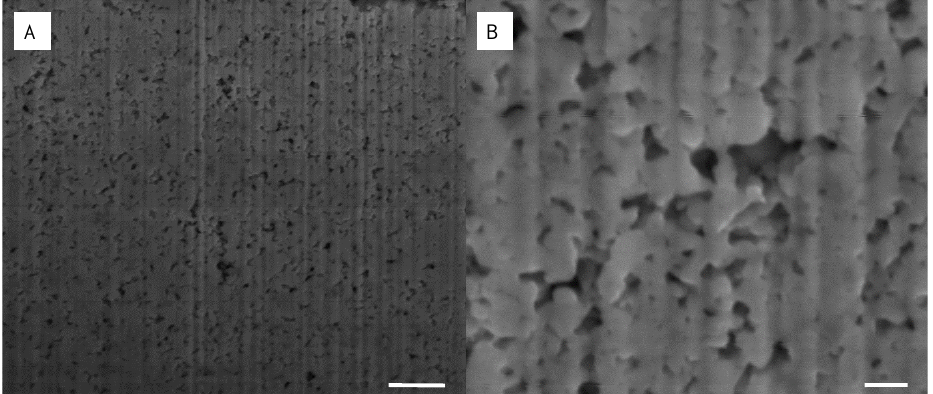
Figure 5. Representative SEMs of the cross-section of an etched 10 wt% SiO 2 -Ag composite; scale bars of ( A ) and ( B ) are 1 μm and 200 nm respectively. The images were taken approximately 10 μm from the surface.